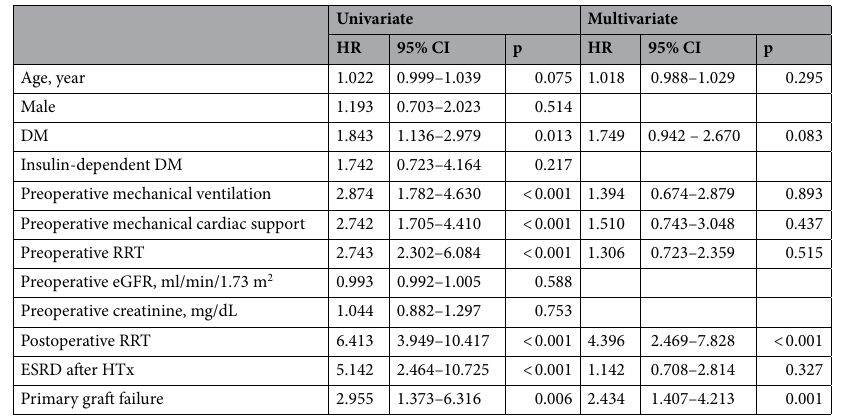
Table 4. Univariate and multivariate analysis to predict all-cause mortality after HTx. DM diabetes mellitus, RRT renal replacement therapy, eGFR estimated glomerular filtration rate, HTx heart transplantation, ESRD end-stage renal